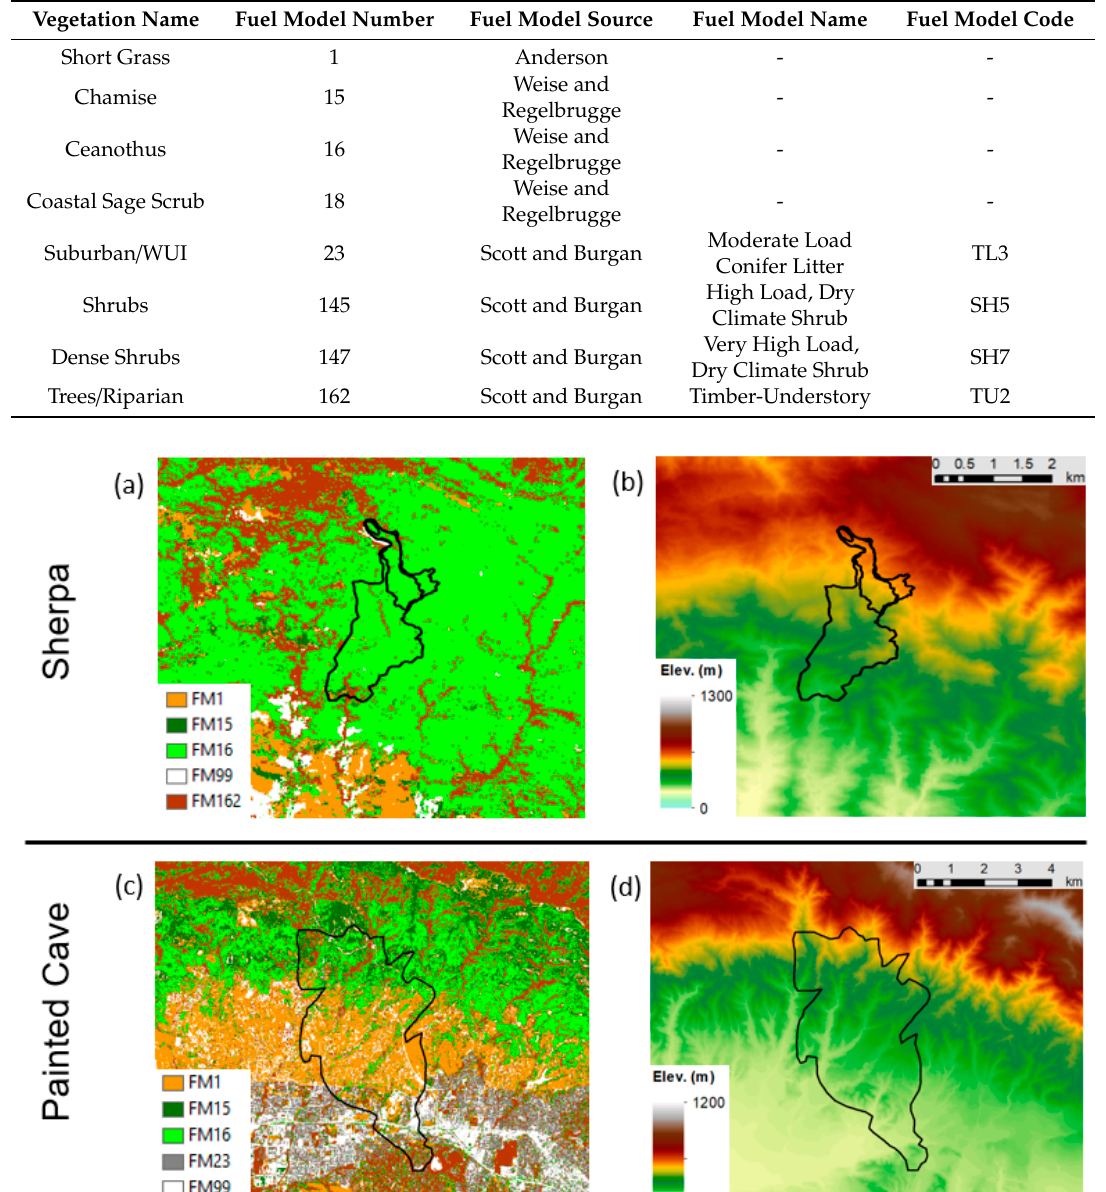
Table 2. Fuel model information.